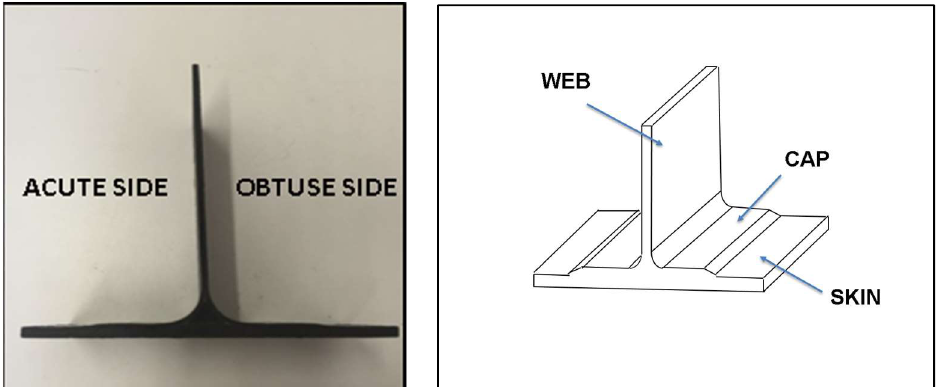
Figure 1. T-Pull specimen and technical nomenclature.